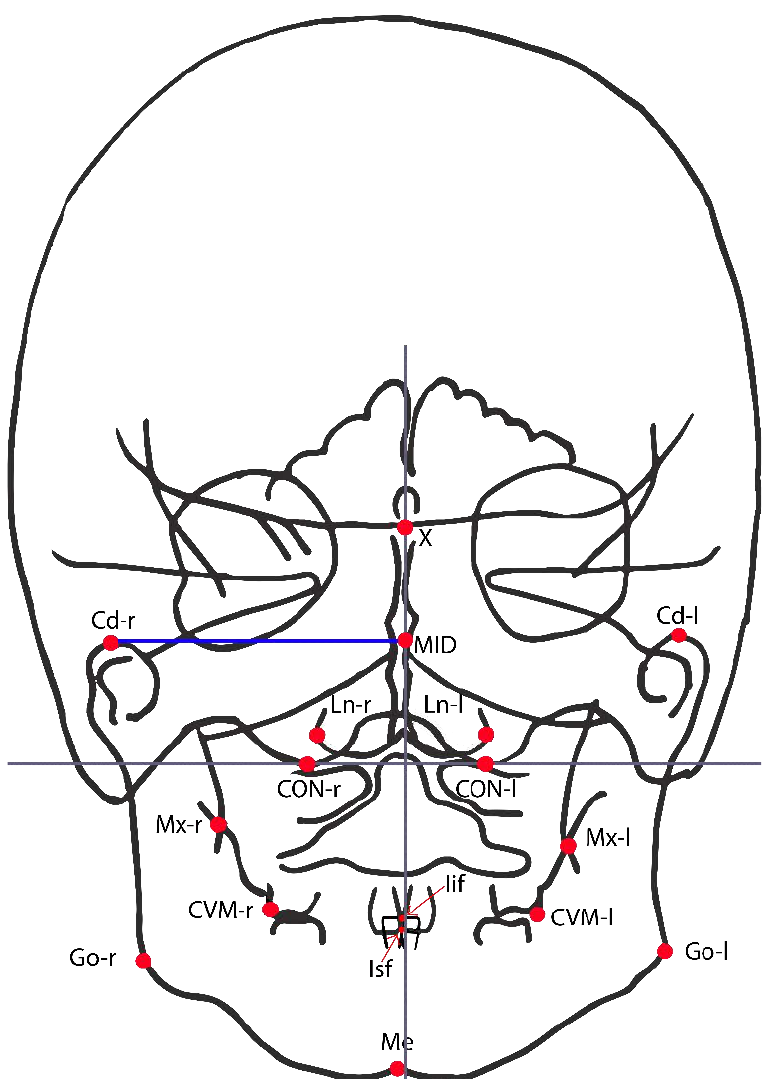
Figure 1. Cephalometric landmarks used in the present study on postero-anterior cephalogram. CVM + r / l = Upper intermolar point (most prominent point on the sagittal plane of the vestibular-mesial cuspid-upper left and upper right first permanent molar); Ln r / l = Lateronasal (external points at the maximal horizontal diameter of nasal cavity); X = Crossing point between the perpendicular plate of the ethmoid and the projection of the floor of the anterior cranial fossa floor; Ans = Anterior cephalometric nasal spine; Mx r / l = Maxillare (the intersection of the lateral contour of the maxillary alveolar process and the lower contour of the maxilla-zygomatic process of the maxilla); Cd r / l = Condylar (the most superior point of the condylar head); Go r / l = Gonion (the point located at the gonial angle of the mandible); Me = Menton (is the most inferior midpoint of the chin on the outline of the mandibular symphysis); Iif = Incision inferior frontale the midpoint between the mandibular central incisors at the level of the incisal edges; Isf = Incision superior frontale (incision superior frontale, the midpoint between the maxillary central incisors at the level of the incisal edges); MID = Crossing point between the axis of symmetry and the horizontal straight line that connects the homolog cephalometric points; CON = Occipital condilion (point of cephalometric congruence between the inferior condyle of the occipital bone and the contour of the great occipital foramen); Axis of reference = Axis passing through right and left CON; Axis of symmetry = Perpendicular to the reference axis, passing through the highest point of the occipital foramen.